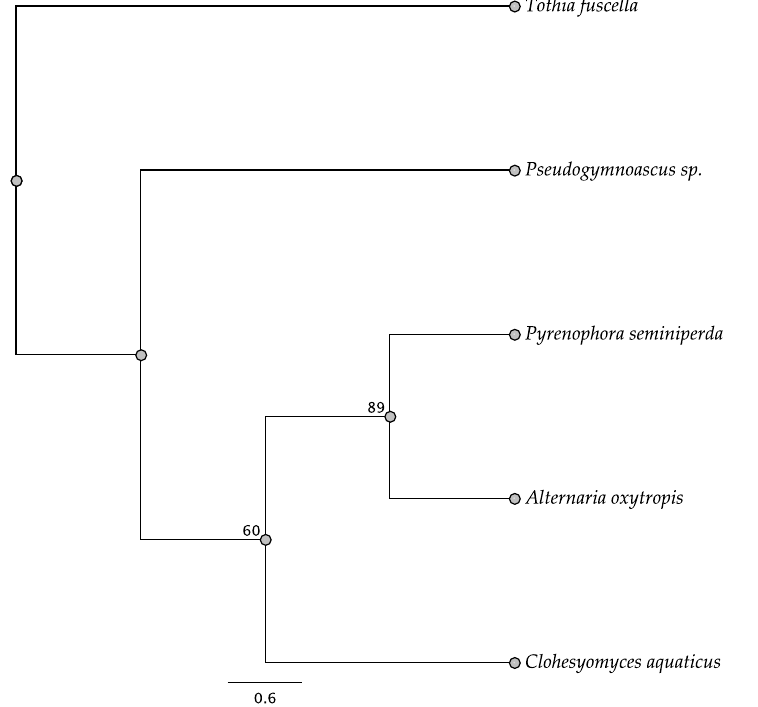
Figure 12. Maximum parsimony DNA tree resulting from the analysis of the swnK – swnR intergenic region sequence data. Bootstrap confidence values from 1000 bootstrap replicates are presented at each corresponding node. Fungal orders are indicated next to each organism/clade.